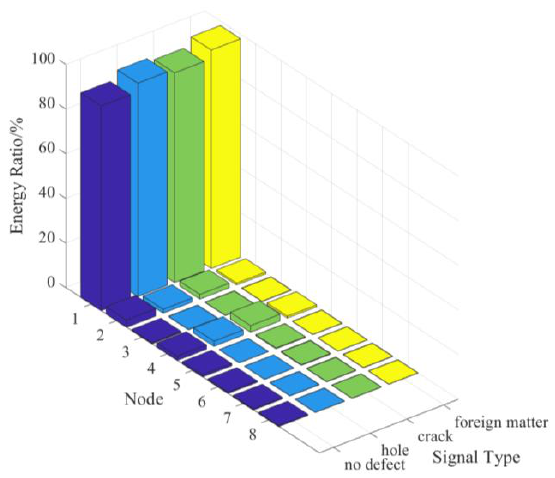
Figure 10. The single cycle ultrasonic